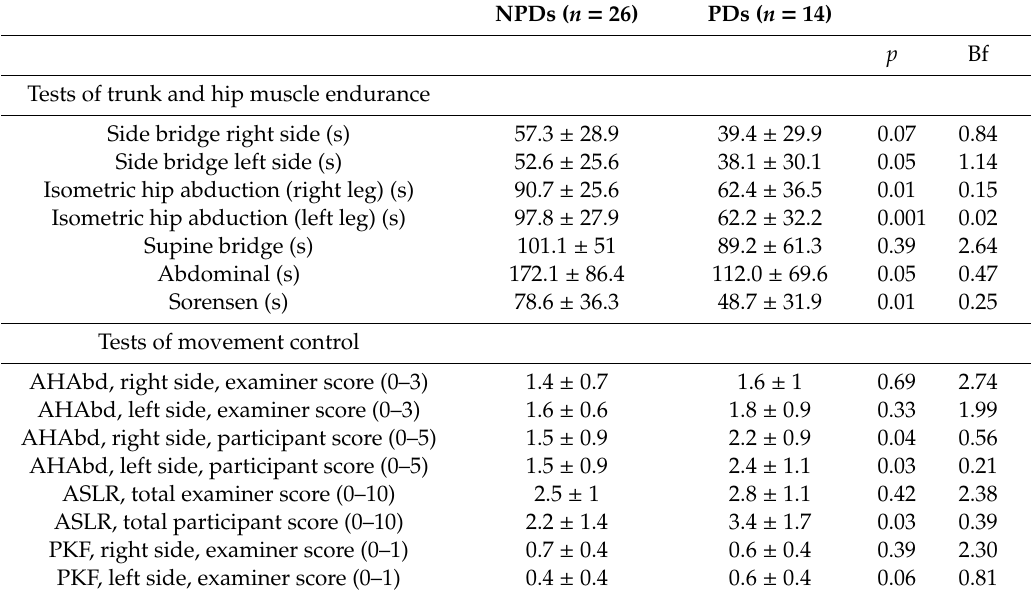
Table 2. Di ff erences in physical outcome measures for non-pain developers (NPD) and pain developers (PD).